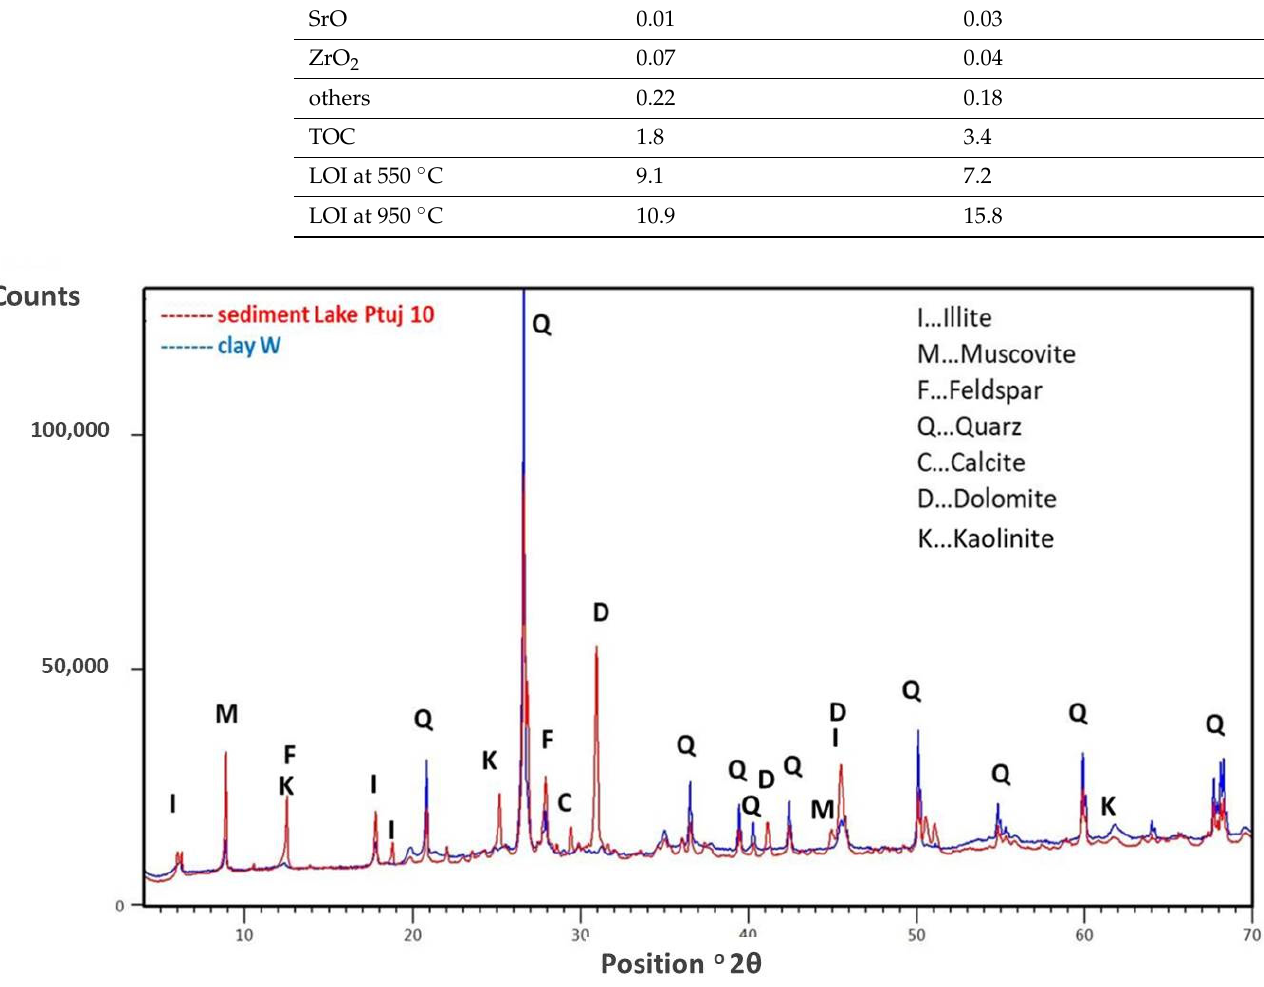
Figure 3. XRD diffractograms—mineralogical compositions of the Lake Ptuj 10 sediment and the clay W.